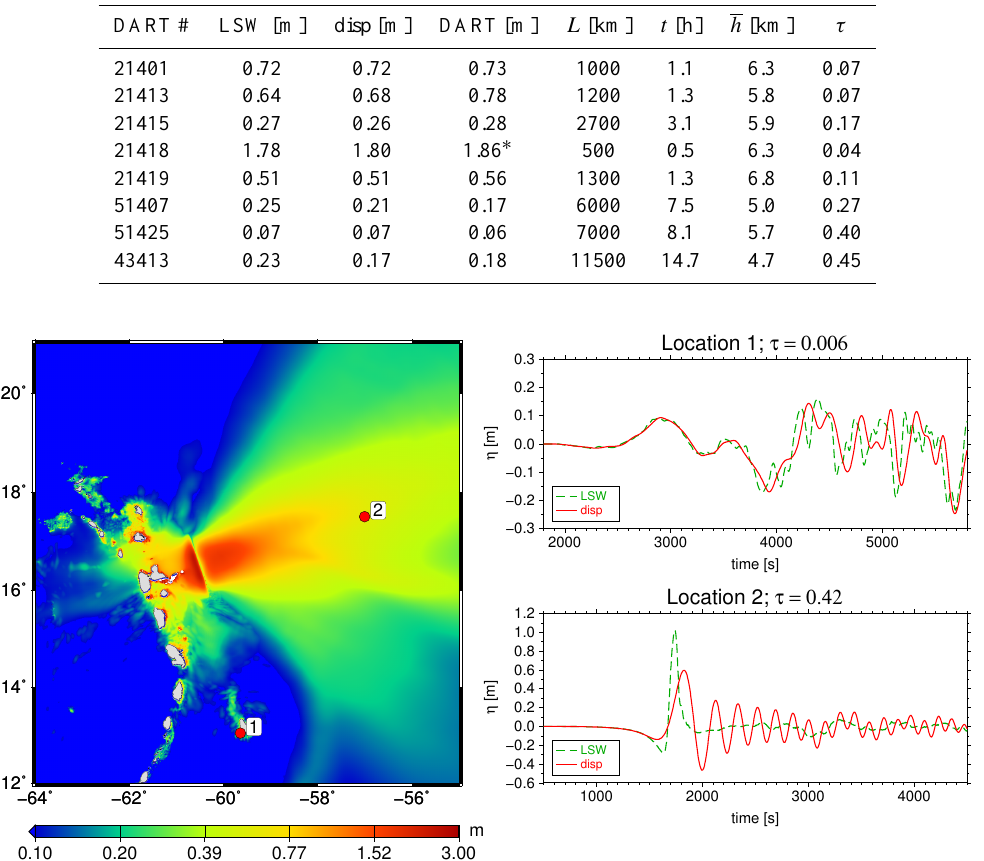
Fig. 10. The maximum surface elevations for the linear hydrostatic solution is shown to the left. The locations of the mariograms are indicated with the numbers 1 and 2, with the corresponding results shown in the upper and lower right panels.